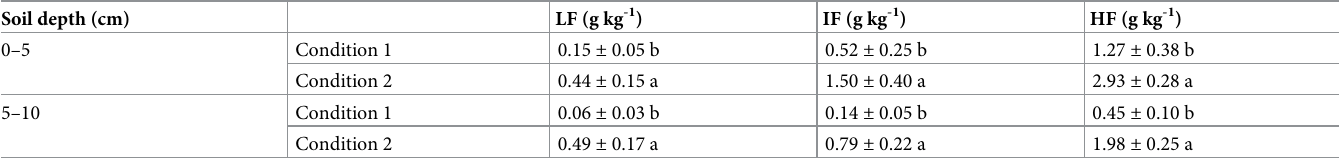
Table 2. Distribution (g kg -1 ) of macro-organic fractions studied.